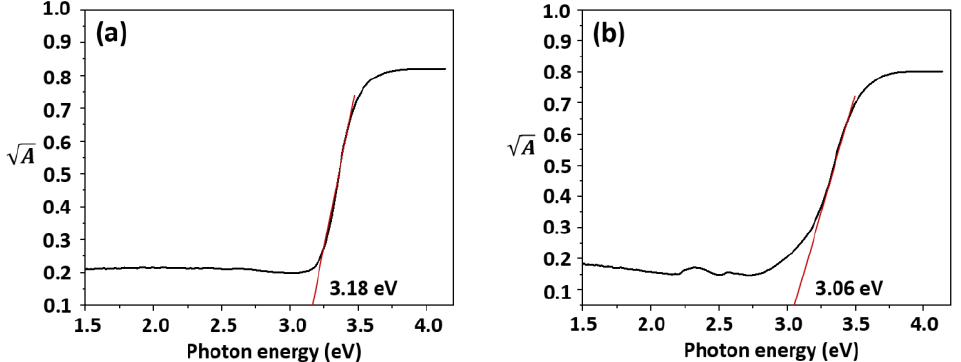
Figure 3. Tauc plots for the estimation of optical bandgaps of ( a ) Ti-600 and ( b ) UV100.